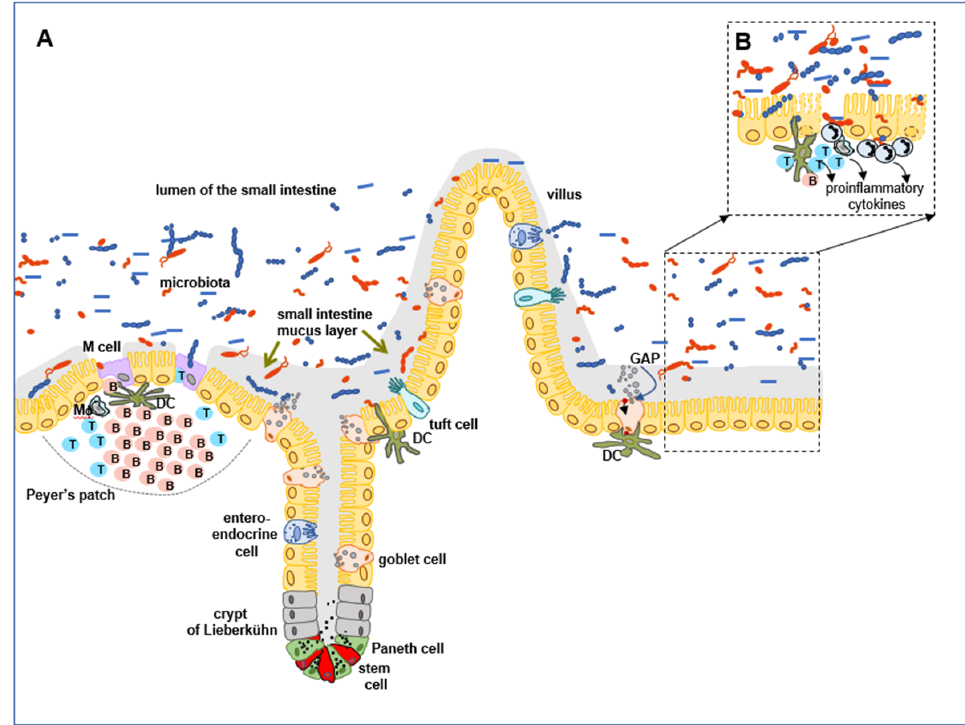
Figure 1. A representative schematic of villi, crypts of Lieberkühn and Peyer’s patches of the small intestine (according to [9]). ( A ) Constantly dividing stem cells, located at the base of the crypts of Lieberkühn, intercalating with Paneth cells, give rise to the progenitor cells differentiating into mature intestinal epithelial cells. Paneth cells, due to the proximity of stem cells and secretion of specific mediators, are considered to be protectors of this population. Moreover, they are the major source of antimicrobial peptides found in the mucus of the small intestine, and are responsible for controlling the gut microbiota, preventing its overgrowth, and inhibiting inflammation. Enterocytes, absorptive cells, comprise the most numerous populations, and together with goblet cells, are found in the crypt-villus axis, and follicle-associated epithelium (FAE). Goblet cells are responsible for the formation of the mucus layer covering the small intestine epithelium, due to the secretion of mucin MUC2. The mucus barrier in the small intestine is penetrable for microbiota. Goblet cells also facilitate luminal antigen sampling and their transport to the lamina propria located dendritic cells via goblet cell-associated passages (GAPs). FAE overlying Peyer’s patch, contain scattered, devoid of mucus layer M cells, which participate in direct sampling of luminal antigens, translocating them to the basolateral site where antigen presenting cells, located in lamina propria , can capture, process, and present them, inducing tolerance or antigen-specific immune response. Tuft cells and enteroendocrine cells are sparse in the intestinal lining. They are involved in protection against helminth infection or secrete peptides and hormones which stimulate, among others, intestinal peristalsis. ( B ) Disturbance of the mucus barrier results in penetration and direct contact with epithelial cells with microorganisms. This results in inflammatory response induction, recruitment of neutrophils, induction of dendritic cells and macrophages localized in lamina propria , stimulation of T cells and B cells, and secretion of proinflammatory cytokines. Inflammatory response leads to the injury of epithelial cells. The large intestine (colon) that connects to the small intestine from one end and the anus at the other, comprises four parts: the cecum, colon, rectum, and anal canal. It is an important part of the digestive system and participates in reabsorbing water, absorbing some vitamins, and processing undigested food material (e.g., fiber). Colonic mucosa is devoid of villi, however, it contains deep tubular crypts that increase in depth towards the rectum. Absorptive, columnar cells, endocrine cells, goblet cells, and stem cells form colon epithelium. There are no Paneth cells. Epithelial cells are renewed every 6 days [10].